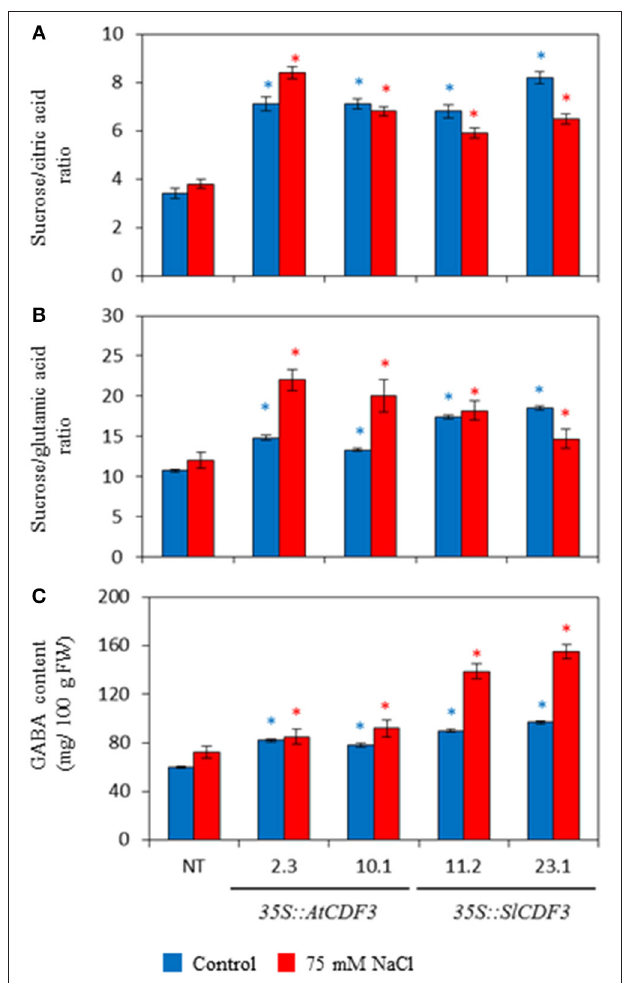
FIGURE 6 | Effect of the overexpression of the Arabidopsis and tomato CDF3 genes on the compounds and variables related to organoleptic quality in tomato fruits. 35S::AtCDF3 (lines 2.3 and 10.1) or 35S:SlCDF3 (lines 11.2 and 23.1) and NT tomato plants were cultured under control (blue bars) and salinity (75mM NaCl, red bars) in the greenhouse from December to mid-August. Four representative fruits, until the 3rd truss, were collected from each plant in the mature-red stage. The sucrose equivalents/citric acid (A) and sucrose equivalents/glutamic acid (B) ratios and GABA content (C) are displayed. Asterisks indicate significant differences ( P < 0.05) of the transgenic plants with the non-transformed plants (NT) under the same growth condition.